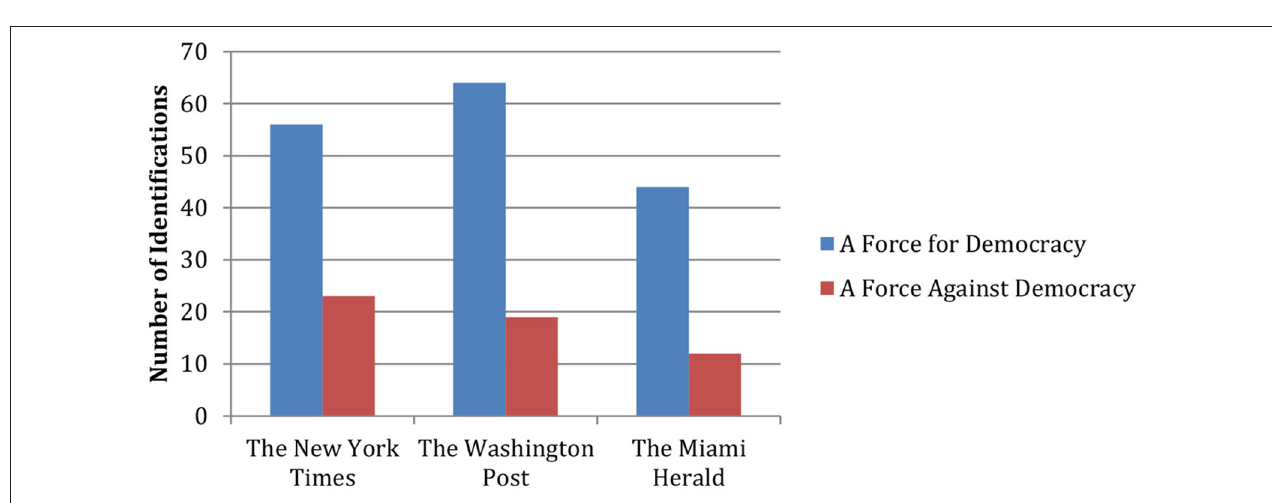
FIGURE 2 | The US: A Force for Democracy? 2014 Newspaper Identifications.